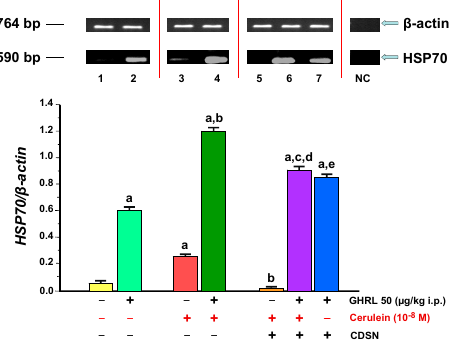
Figure 10. Analysis of heat shock protein 70 (HSP70) gene expression assessed using RT-PCR and densitometric analysis of HSP70/ β -actin mRNA ratio in isolated pancreatic acinar cells: (lane 1) acinar cells obtained from control sensory nerves (SN)-intact rats treated with saline, after isolation, acinar cells incubated in cerulein-free solution; (lane 2) acinar cells obtained from SN-intact rats treated with ghrelin (GHRL), after isolation, acinar cells incubated in cerulein-free solution; (lane 3) acinar cells obtained from SN-intact rats treated with saline, after isolation, acinar cells incubated in solution containing cerulein at a concentration of 10 − 8 M; (lane 4) acinar cells obtained from SN-intact rats treated with GHRL, after isolation, acinar cells incubated in solution containing cerulein at a concentration of 10 − 8 M; (lane 5) acinar cells obtained from rats with capsaicin deactivation of SN (CDSN) and treated with saline, after isolation, acinar cells incubated in solution containing cerulein at a concentration of 10 − 8 M; (lane 6) acinar cells obtained from rats with CDSN and treated with GHRL, after isolation, acinar cells incubated in solution containing cerulein at a concentration of 10 − 8 M; (lane 7) acinar cells obtained from rats with CDSN and treated with GHRL, after isolation, acinar cells incubated in cerulein-free solution. NC = negative control. Reference gene: β -actin . a p < 0.05 compared to control acinar cells obtained from rats with intact SN (lane 1); b p < 0.05 compared to acinar cells stimulated with cerulein after isolation from SN-intact rats treated with saline (line 3); c p < 0.05 compared to acinar cells stimulated with cerulein after isolation from rats with CDSN and treated with saline (lane 5); d p < 0.05 compared to acinar cells stimulated with cerulein after isolation from SN-intact rats treated with GHRL (lane 4); e p < 0.05 compared to acinar cells incubated in cerulein-free solution after isolation from SN-intact rats treated with GHRL (lane 2). In each experimental group, there was at least six